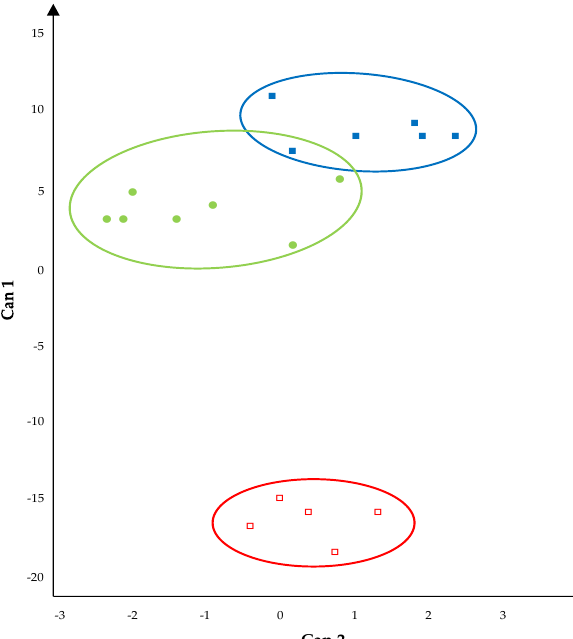
Figure 3. Plot of Canonical 1 × Canonical 2 – variable: relative abundance of OTUs detected on wooden shelves biofilm. Symbols: ▪, wooden shelves used for the ripening of TAP Caciocavallo Palermitano cheese; ●, wooden shelves used for the ripening of PDO Pecorino Siciliano cheese; ▫, wooden shelves us ed for the ripening of Piacentinu Ennese cheese. Centroids coordinates: ▪ (8.61; −1.07); ● (−15.74; 0.31); ▫ (3.85; − 1.14).